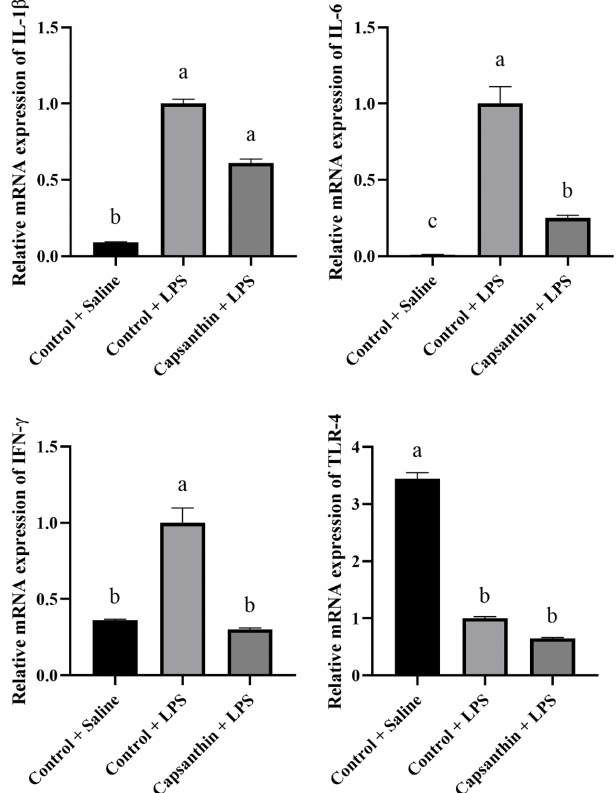
Figure 2. Relative mRNA levels of splenic interleukin-1 β (IL-1 β ), interleukin-6 (IL-6), interferon- γ (IFN- γ ), and toll-like receptor 4 (TLR-4) in broiler chickens. Control + saline: chickens fed a basal diet with isotonic saline injection. Control + LPS: chickens fed a basal diet under E. coli O55:B5 LPS challenge. Capsanthin + LPS: chickens fed a diet supplemented with capsanthin at 80mgkg − 1 under E. coli O55:B5 LPS challenge ( n = 6 / treatment). Data are presented as means ± standard errors of the mean. The impact was analyzed by one-way ANOVA, and differences among the groups were considered significant at P< 0 . 05. Means with a, b, and c differ significantly at P< 0 .